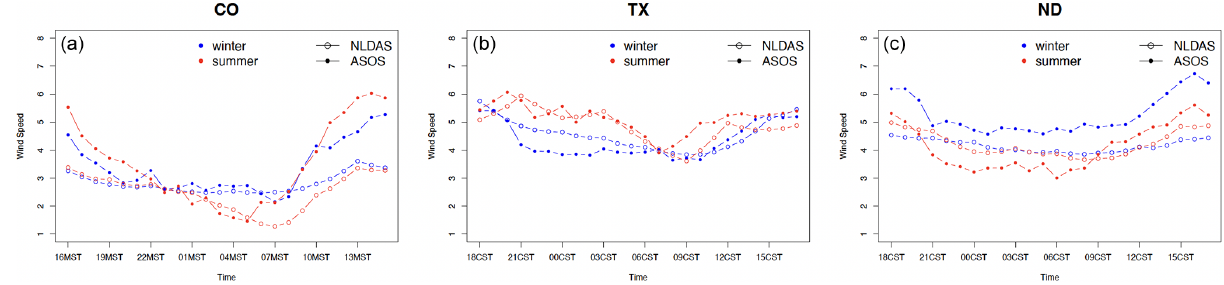
Figure 4. Diurnal wind speed pattern of NLDAS and ASOS wind data for the three inland locations in Colorado (CO), Texas (TX), and North Dakota (ND), from left to right, displayed in winter (blue) and summer (red). Diurnal cycles are computed as the averages of January and February 2018 for winter and June and July 2018 for